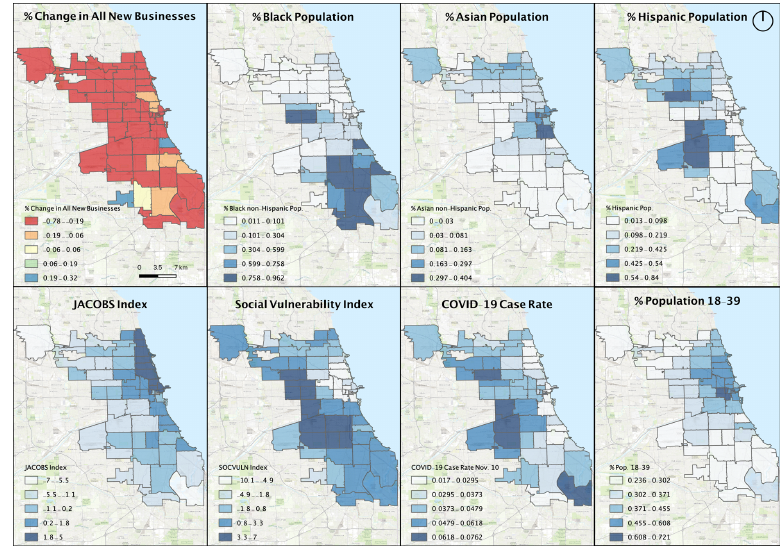
Figure 8: Panel map showing spatial distribution of the primary dependent variable and covariates used in the regression